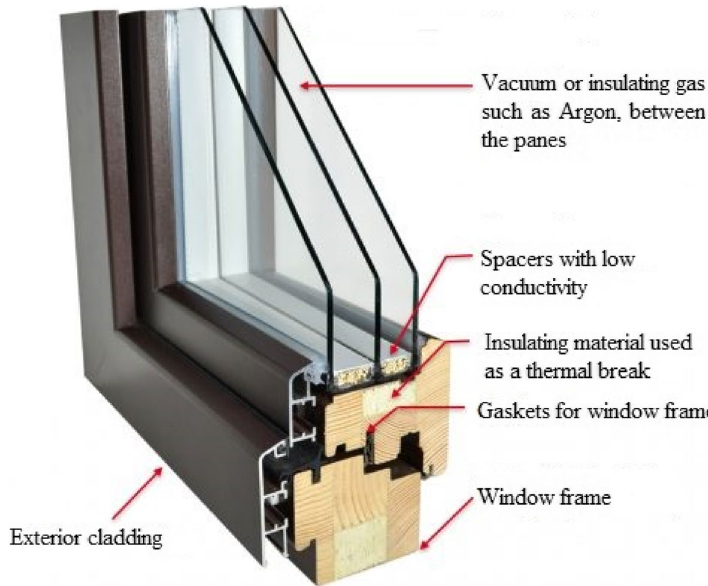
Fig. 5 A typical multi-pane window for insulating indoor